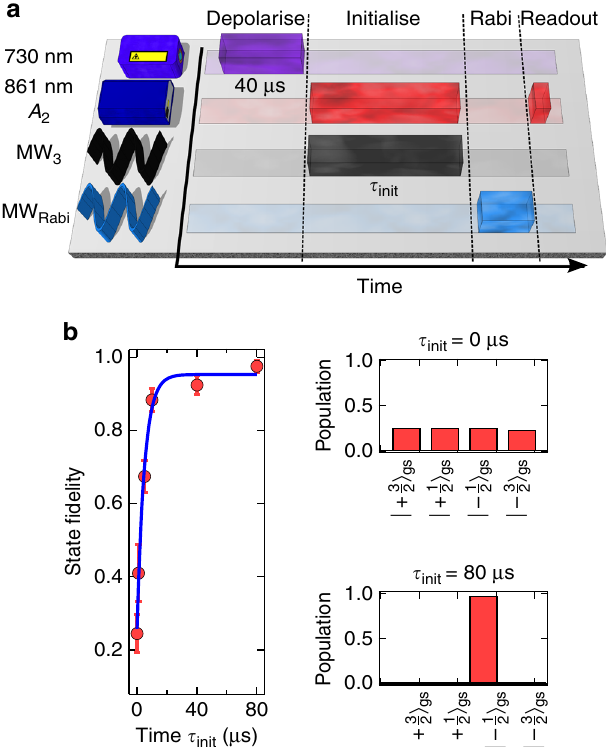
Fig. 4 Electron spin initialisation fi delity. a Experimental sequence. Before each round, the ground state spin is depolarised using off-resonant excitation for 40 µ s. Then, the system is initialised into (cid:1) 1 state populations are inferred from Rabi oscillations and resonant optical readout. b Left side: Spin population in (cid:1) 1 of the initialisation procedure. Up to 97.5% are achieved. The blue line is a fi t using an exponential function. The error bars are estimated from the uncertainties in determining populations of the ground spin states, assuming that the main source of error is shot noise. Right side: Inferred spin populations in the four ground state sublevels without initialisation (top) and after 80 µ s initialisation